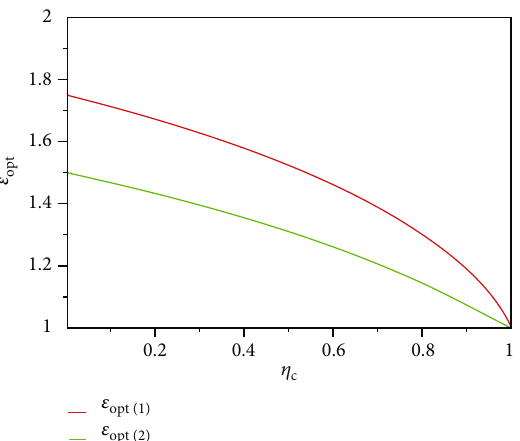
Figure 7: The ratio of optimized period for the two cases of optimization criteria to the period at maximum power versus the Carnot e ffi ciency.